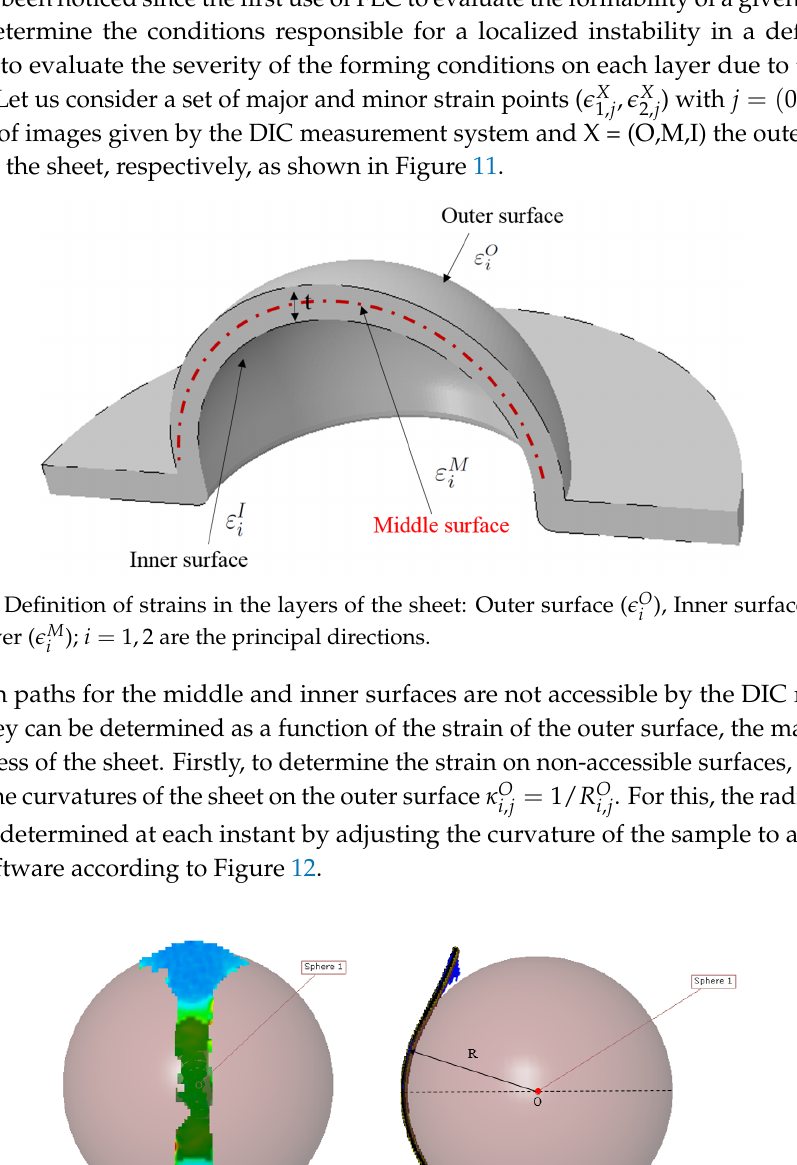
Figure 12. Aramis procedure for the determination of the radius of curvature, adjusting the curvature of the sample to a